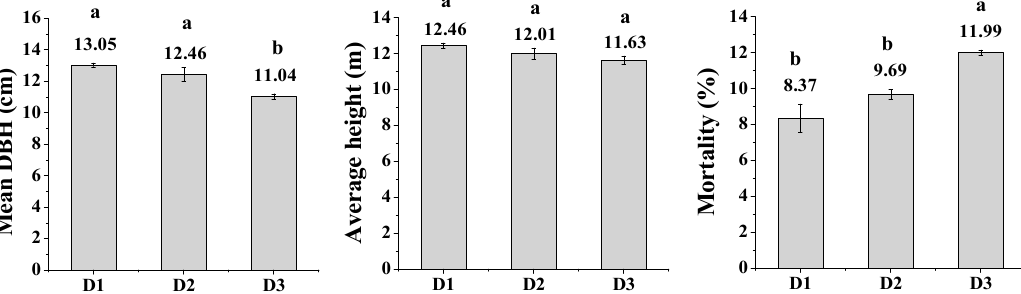
Figure 3. Mean diameter, average height and mortality (dead plants) of Chinese fir tree plantation stands with low (D1), intermediate (D2) and high (D3) initial stand density. Values are mean ± SE, and bars with the same letter(s) for each treatment are not significantly different at the 0.05 level of probability.